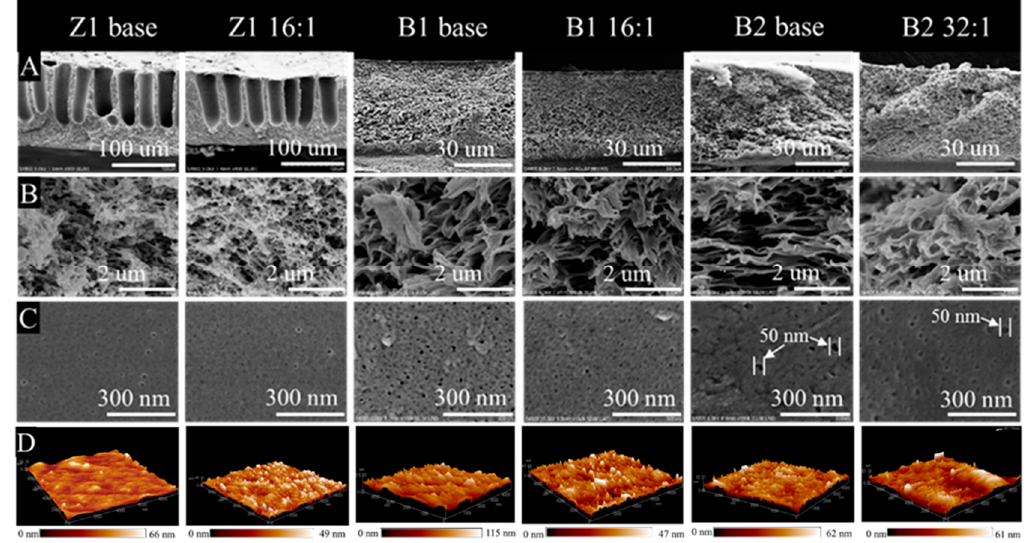
Figure 7. Morphology of membranes. ( A ) and ( B ) cross-sectional SEM images, ( C ) surface SEM images, and ( D ) AFM images of three-dimensional surfaces of the membranes.